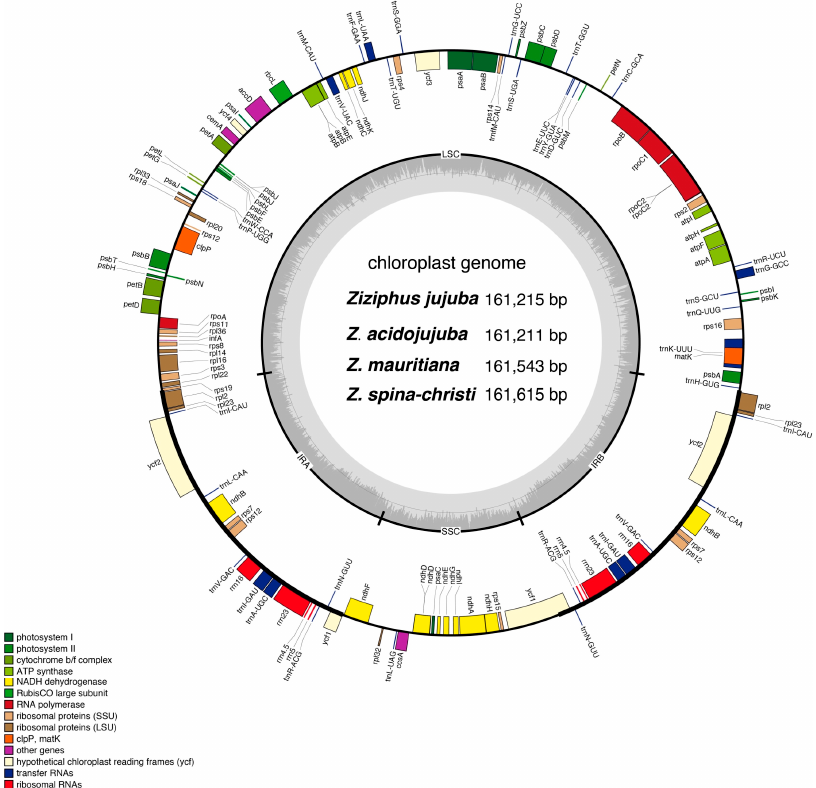
Figure 1. Chloroplast genome assembly, size and features of four Ziziphus species. Genes lying outside of the outer layer circle are transcribed in the counter clockwise direction, whereas genes inside are transcribed in the clockwise direction. The colored bars indicate different functional groups. The darker gray area in the inner circle denotes GC content while the lighter gray corresponds to AT content of the genome. LSC: large single copy, SSC: small-single-copy, IR: inverted repeat.